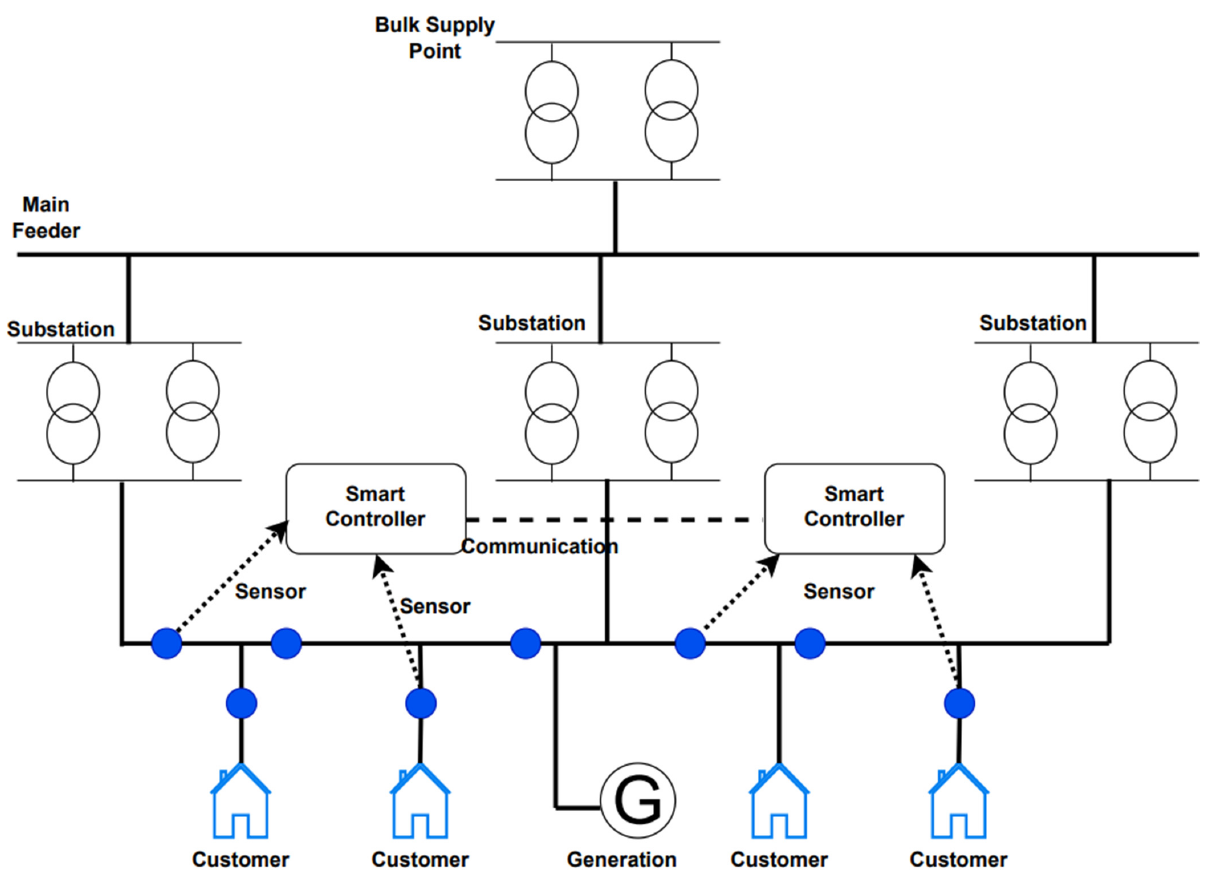
Figure 5. Communication in an independent active control.